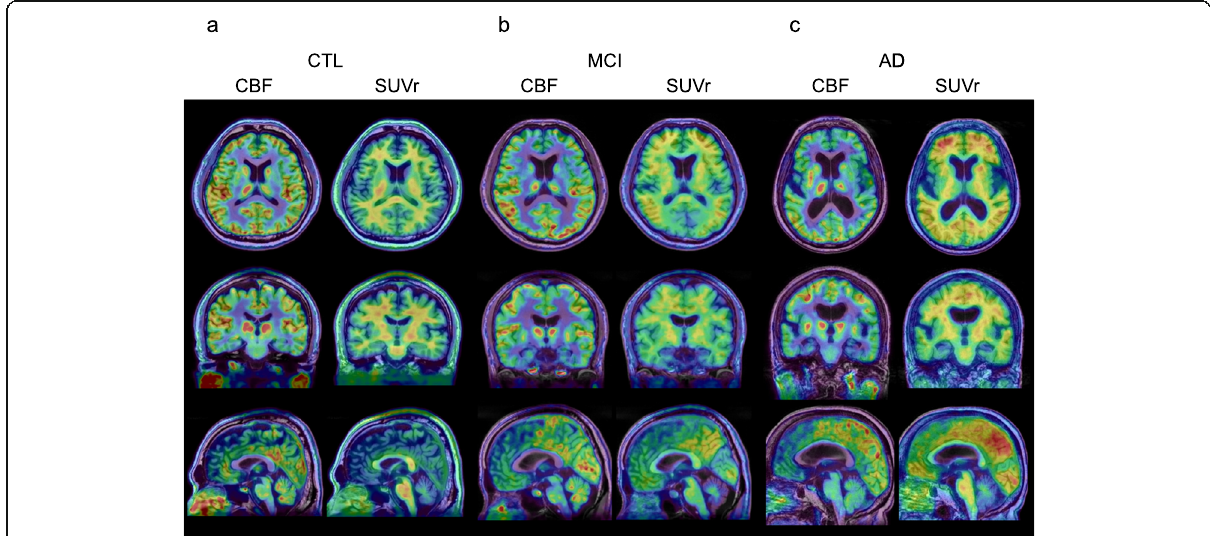
Fig. 1 Representative CBF (left) and SUVr (right) images of healthy control (CTL) ( a ), MCI ( b ), and early AD ( c ) calculated from [ 11 C]PiB-PET. MMSE scores were 30, 29, 25, respectively. SUVr images showed a gradual increase of cortical [ 11 C]PiB accumulation according to severity of the disease, but CBF values were close between controls and MCI patients. CBF (mL/min/100 g) images showed similar distribution between MCI and CTL, while early AD patients showed slight decrease in frontal and temporal lobes. Note the posterior cingulate cortex and the precuneus did not show CBF decrease and gradual SUVr increase in the AD patient